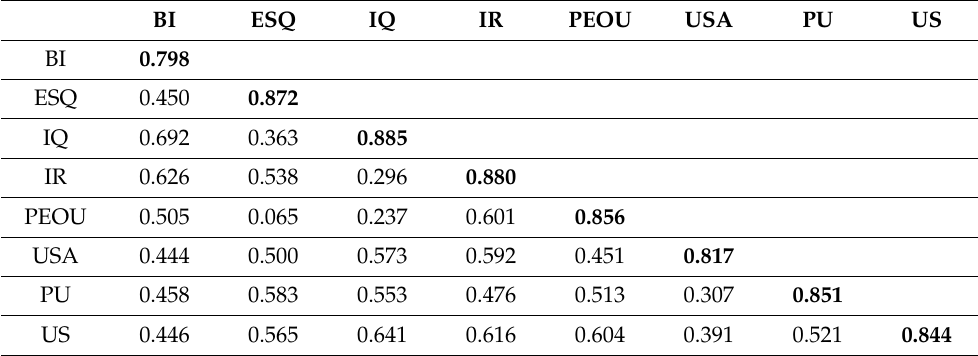
Table 6. Fornell–Larcker Scale.